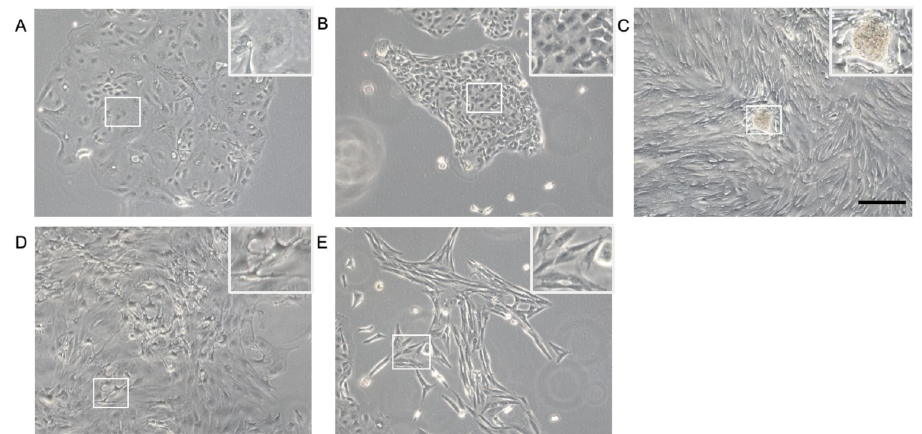
Fig 2. Morphological heterogeneity of primary LG cells in monolayer cultures. Primary cells isolated from porcine LG are cultured in expansion media for 7 days. The populations of large polygonal-like epithelial cells (A), small polygonal-like epithelial cells (B), epithelial spherule (C), dendritic cells (D), and fibroblast-like cells (E) are observed under phase-contrast microscopy at 20X of magnification. Scale bar: 200 μ